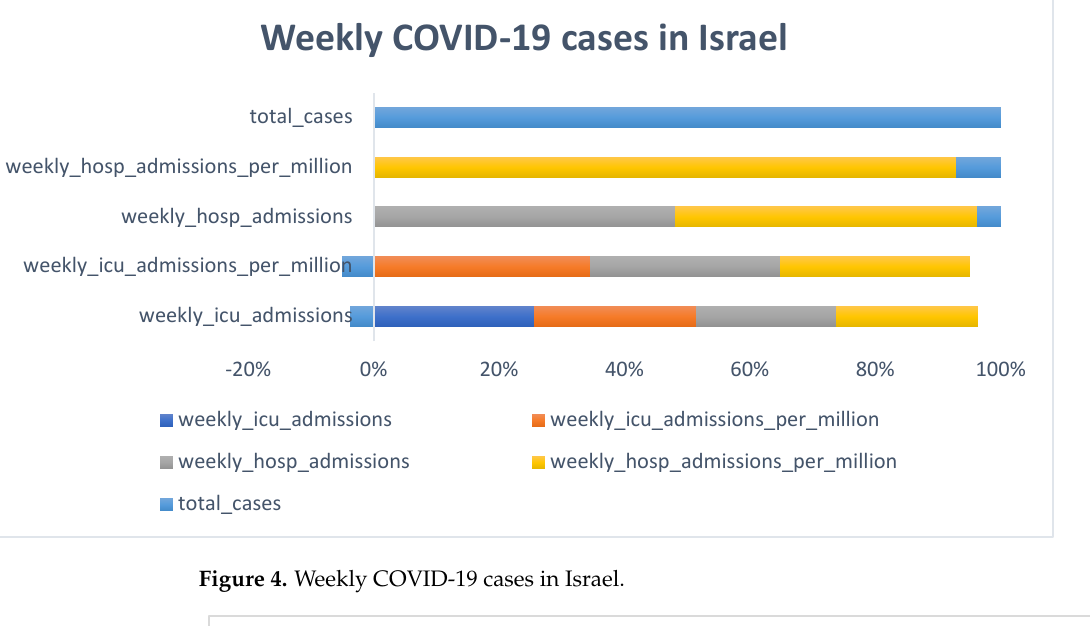
Figure 3. COVID-19 mortality cases in Greece.